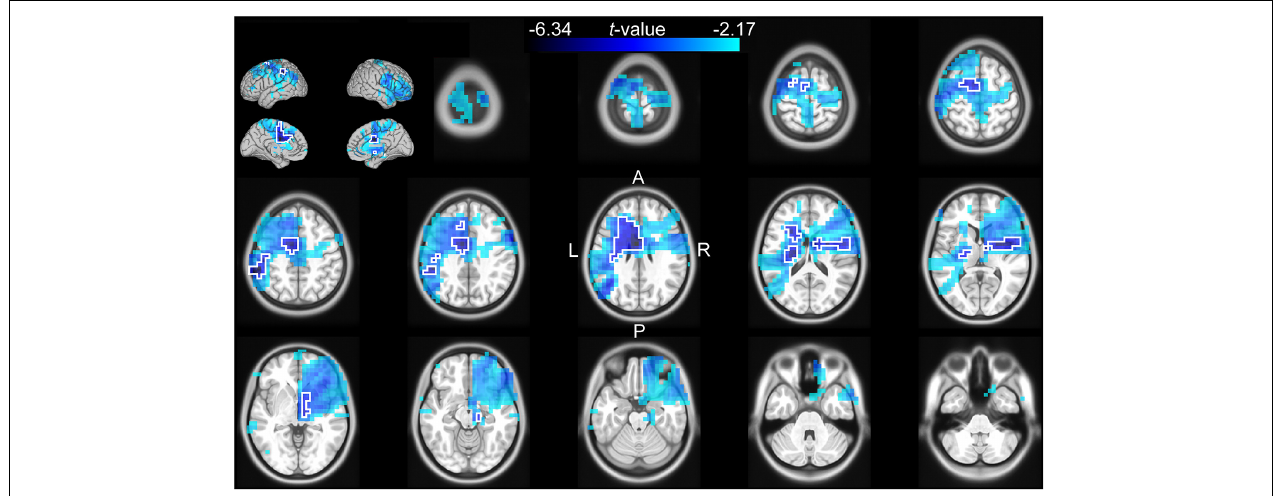
FIGURE 3 | Source analysis of the correlation between the log-transformed beta power and cue reliability during the late cue period (0.5–1 s after cue onset). The t -values of the correlation are mapped onto the transverse slices and surface of the MNI standard brain. The color scale represents negative t -values from the 75th to 100th percentile of the absolute t -value distribution. The cluster-based selected area is surrounded by a white border.